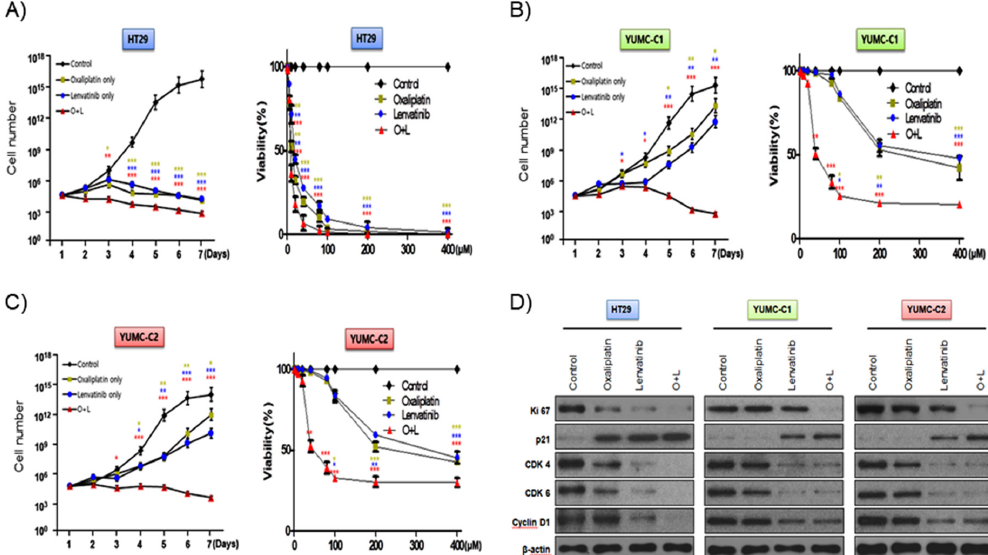
Figure 2. Synergistic anticancer effects of oxaliplatin and lenvatinib on HT-29 cells from American Type Culture Collection (ATCC) and YUMC-C1 and YUMC-C2 patient-derived colon cancer cells. Proliferation assay of ( A ) HT-29, ( B ) YUMC-C1, ( C ) YUMC-C2 cells after treatment with oxaliplatin and lenvatinib alone or in combination. ( D ) Immunoblot analysis of related cell cycle proteins in HT-29, YUMC-C1, and YUMC-C2 cells. Data points are the means (%) of values of the solvent-treated control. All experiments were repeated at least three times. Data are the means ± SD. * p < 0.05, ** p < 0.01, and *** p < 0.005 compared with the control. Collectively, these results suggest that the synergistic effect of oxaliplatin and lenvatinib looked to be potent against drug-resistant and metastatic colon cancer cells.